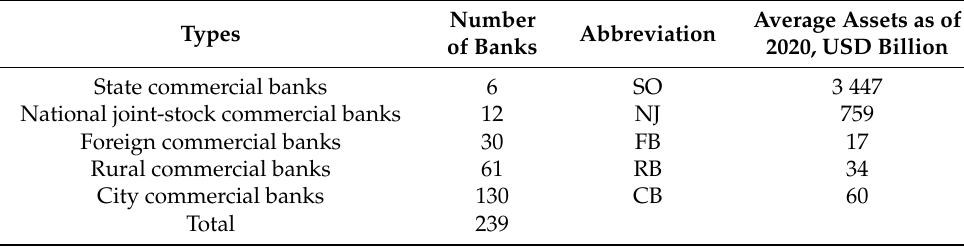
Table 4. Data characteristics by type of